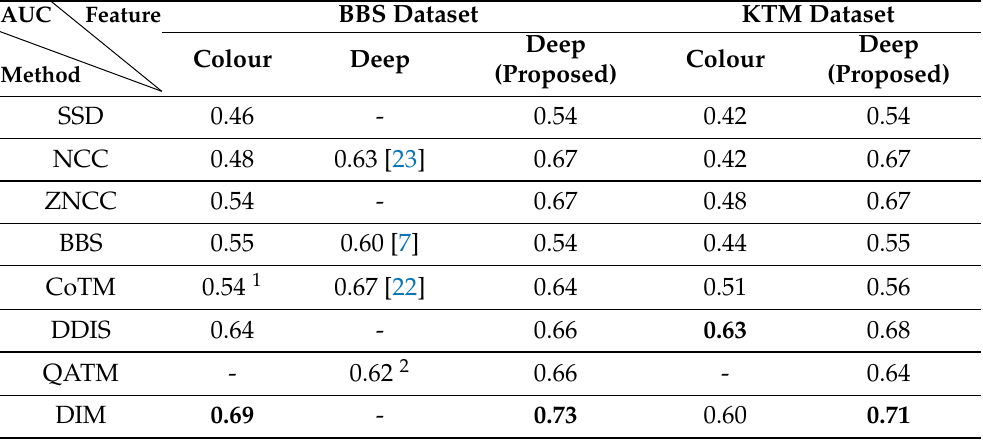
Table 4. Quantitative comparison of the performance of different template matching algorithms using different input